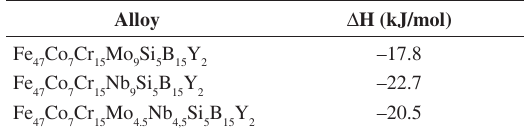
Table 2. Mixing enthalpies values of alloys, ∆